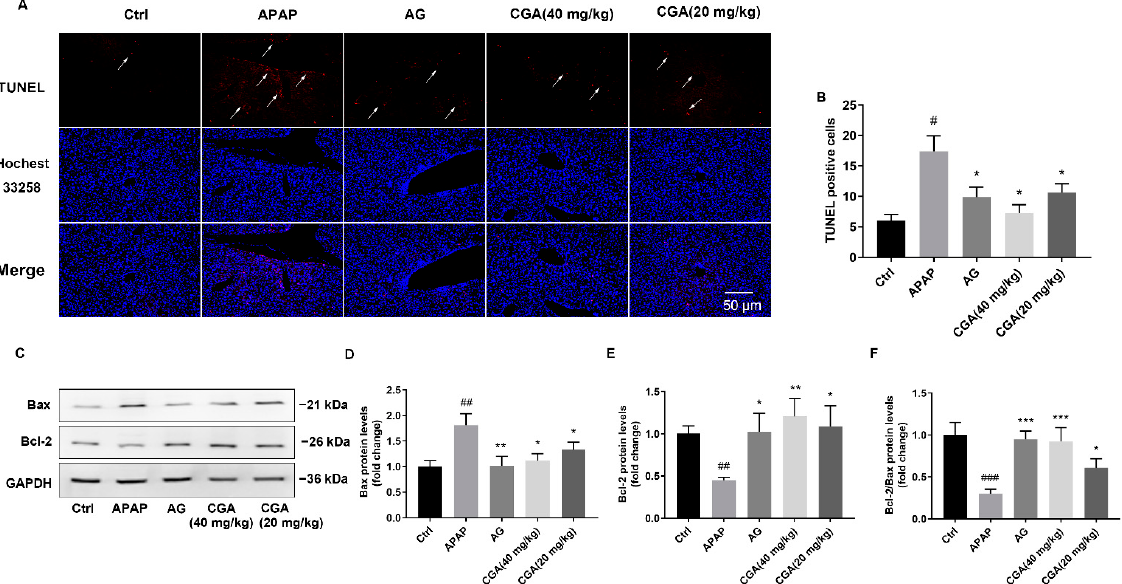
Figure 4. CGA suppressed liver cell apoptosis in APAP hepatotoxicity mice. ( A ) Representative microscopic images of liver cell apoptosis (TUNEL assay, 200 ( × ), scale bar = 50 µ m); the arrows indicate apoptotic cells. ( B ) TUNEL-positive stained cells ( n = 4). ( C ) Representative Western blotting images of Bcl ‐ 2 and Bax in liver tissue. GAPDH was used as an internal standard. ( D – F ) Quantitative analysis of Bcl ‐ 2, Bax, and the ratio of Bcl ‐ 2/Bax in the liver in different groups by Bio ‐ Rad Quantity One v4.62 software. # p < 0.05, ## p < 0.01, ### p < 0.001 vs. Ctrl group; * p < 0.05, ** p < 0.01, *** p < 0.001 vs. APAP group.